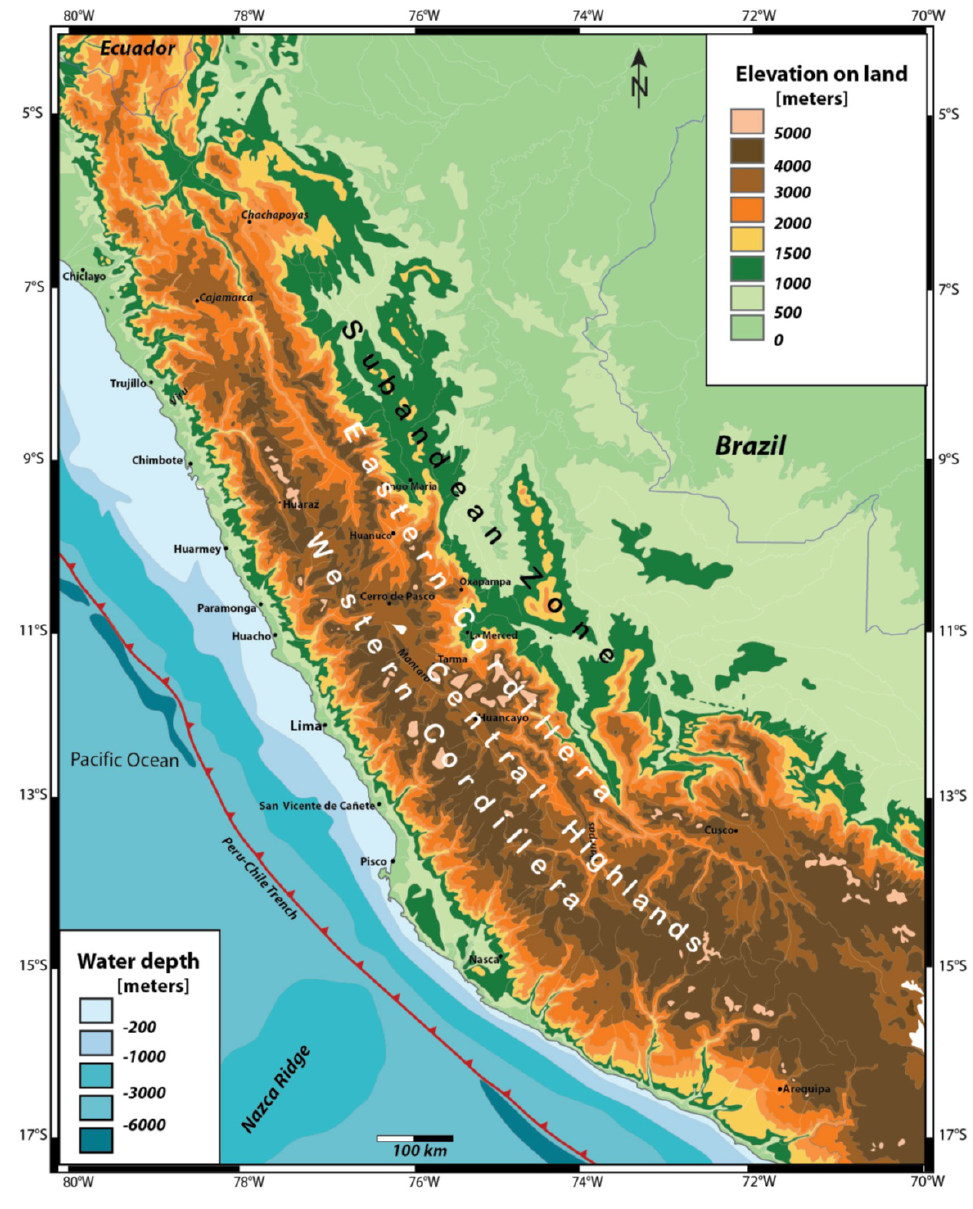
Figure 2. Digital elevation map of the Central Andes based on [7] showing the main geomorphic features. Peaks exceeding elevations of 5000 m are aligned along the Western and the Eastern Cordilleras. The Central Highlands pinch out towards the NNW and widen towards the Altiplano in the